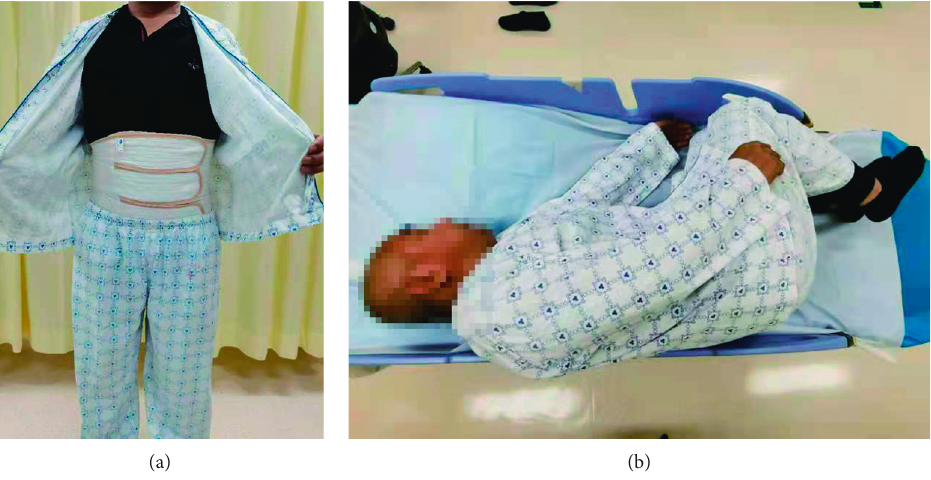
Figure 1: The use of the abdominal bandage.